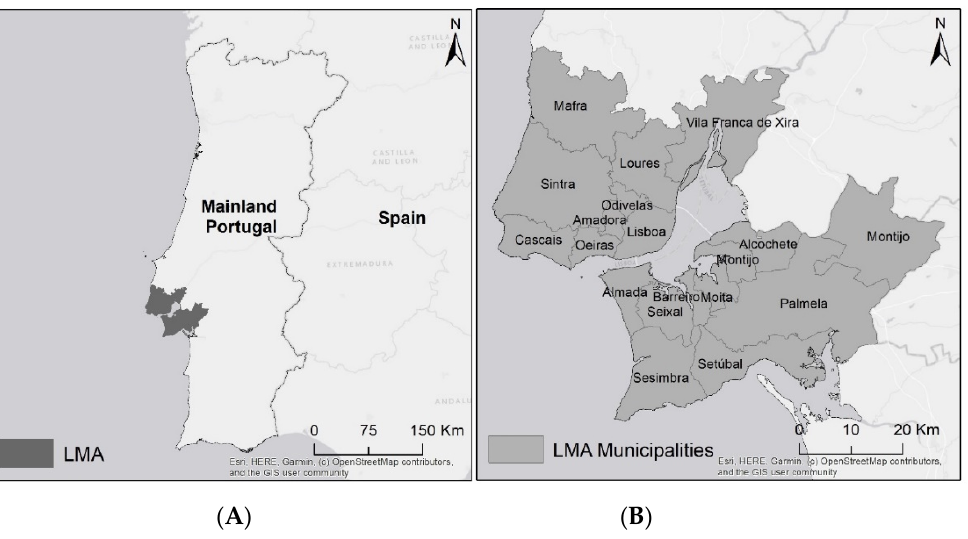
Figure 3. ( A ) Lisbon Metropolitan Area and ( B ) its municipalities.